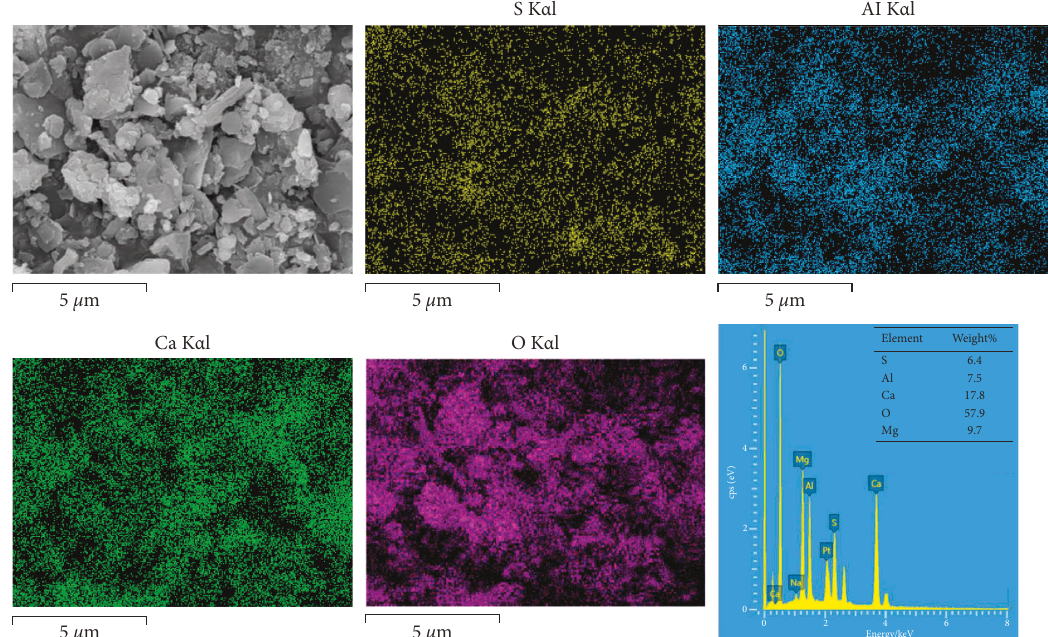
Figure 8: EDS analysis showing elements’ distribution in the precipitates when the added molar ratio of Al :Ca:S is 2: